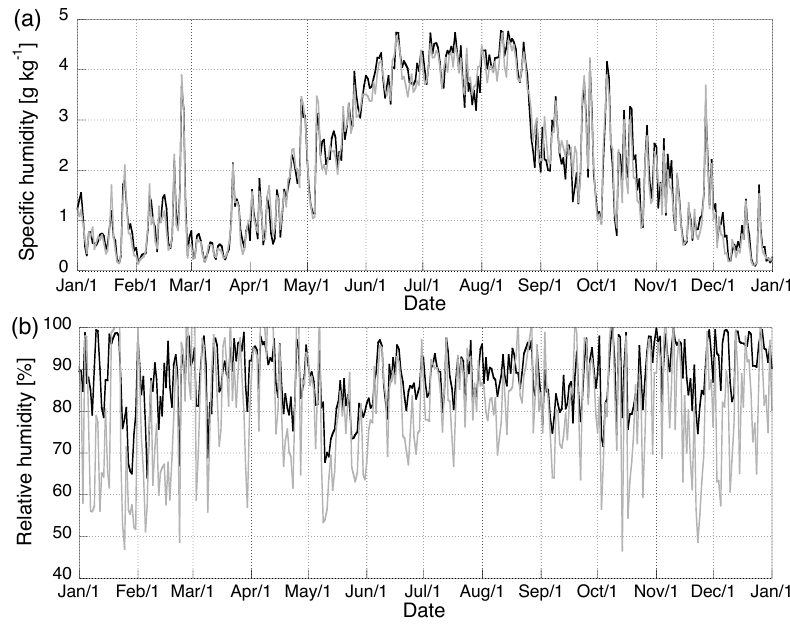
Fig. 9. Comparison of simulated (gray lines) and observed (black lines) 2m daily averages of (a) specific humidity [gkg − 1 ] and (b) relative humidity [%] at S6 for the year